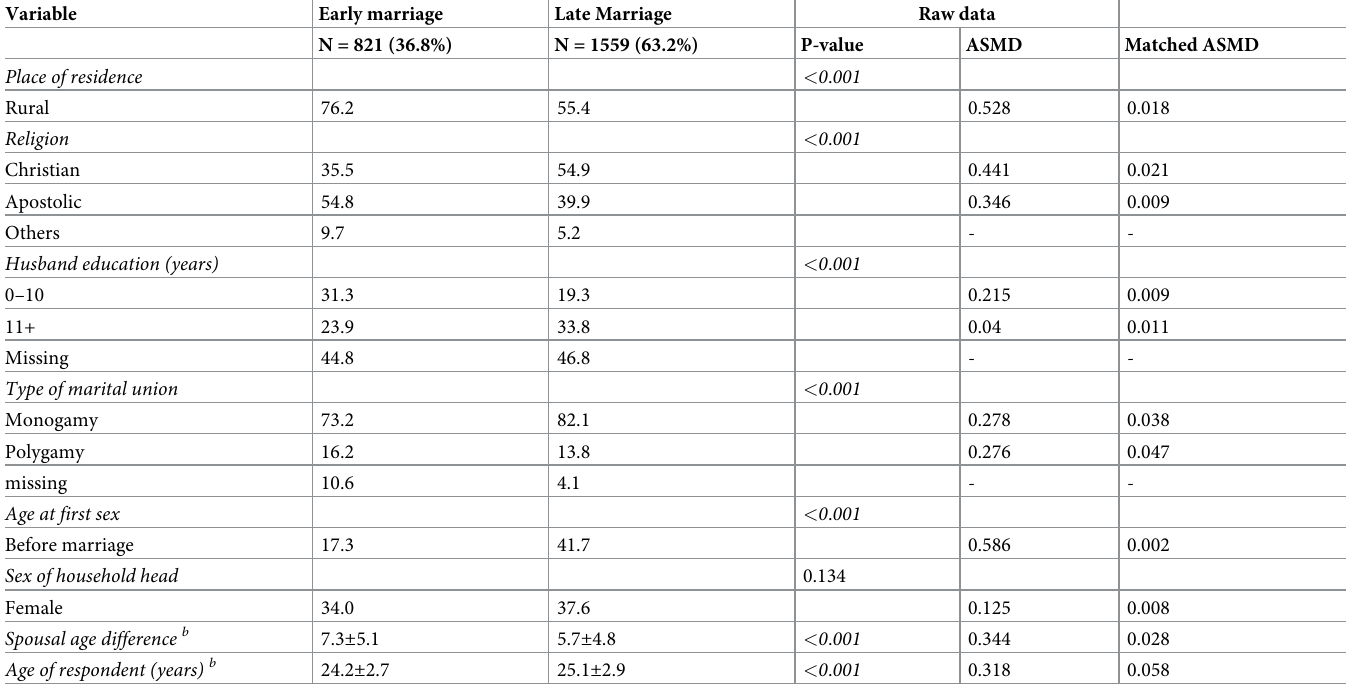
Table 1. Descriptive statistics (% and means) for child marriage, and associations with selected variables of married women aged 20–29, 2015 ZDHS, n = 2380. Variable Early marriage Late